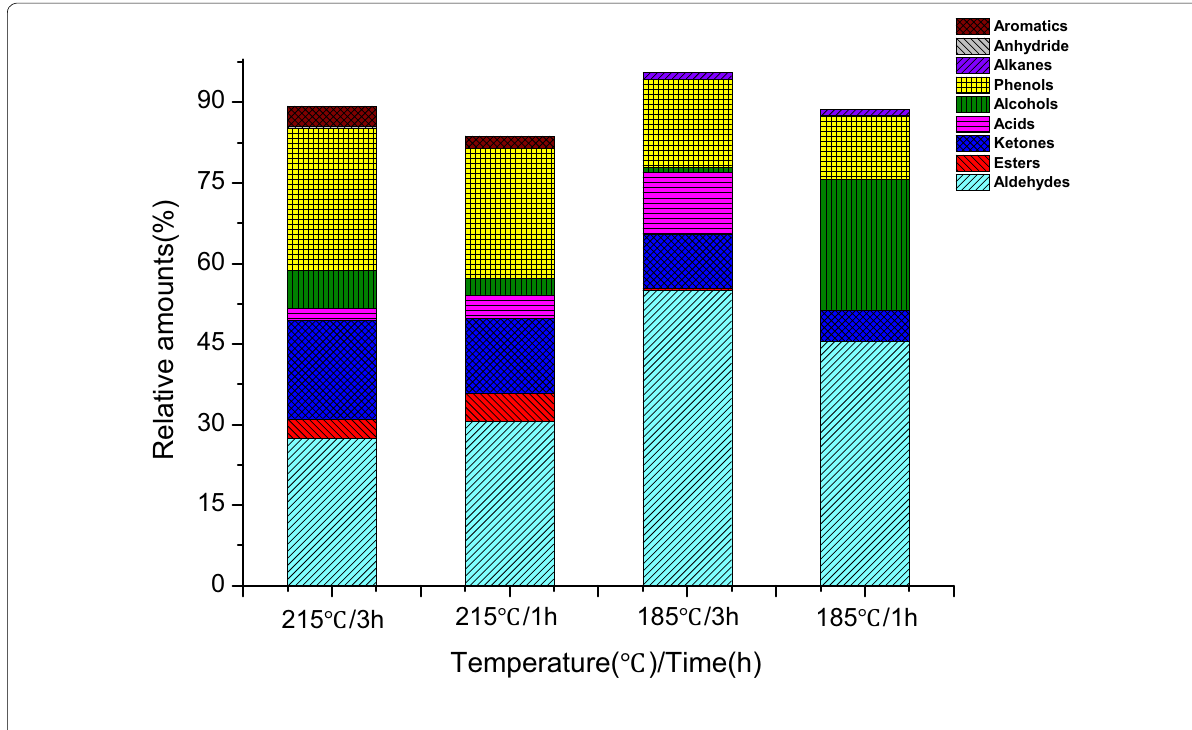
Fig. 5 Relative amounts of the effluents condensated by VOCs of rubberwood from different heat treatment technological parameters